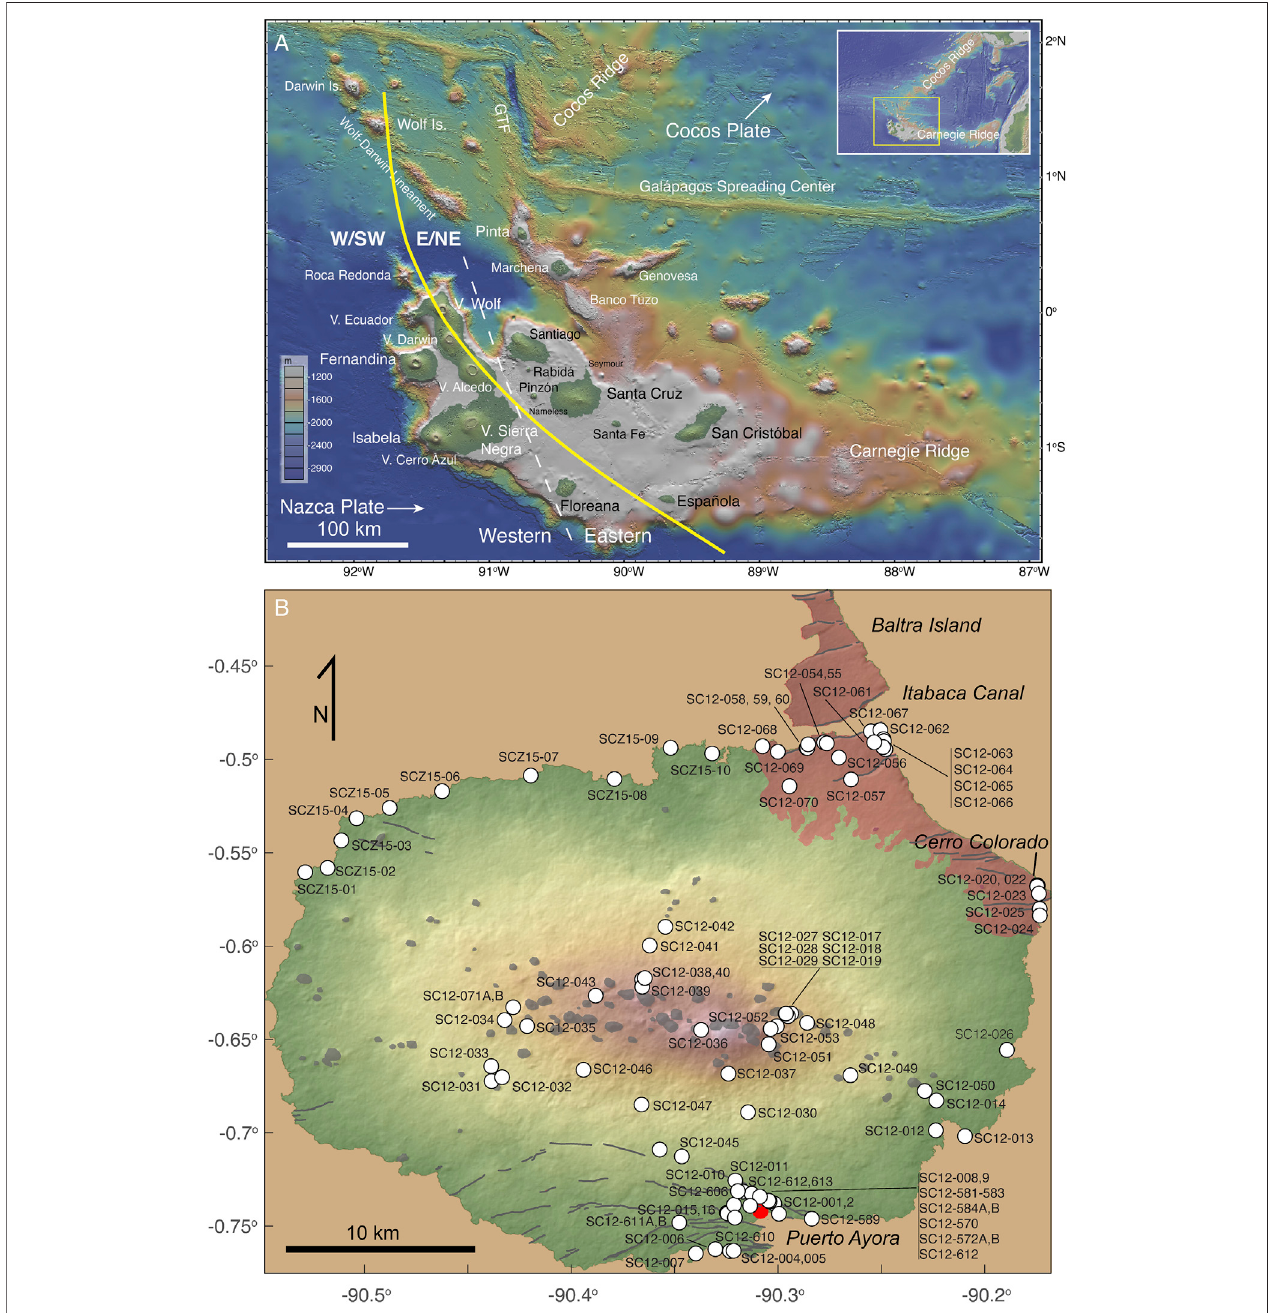
FIGURE 1 | (A) Map of the Galápagos Archipelago. Santa Cruz is located in the central Galápagos. Cocos and Nazca absolute plate motion directions are from Argus et al. (2011). The yellow line denotes the boundary between the enriched, LLSVP-sourced stripe on the W/SW side of the plume and the less enriched, ambient mantle-sourced stripe on the E/NE side of the plume; see text for discussion and Harpp and Weis (2020) for further details. The white dashed line indicates the line betweenthewesternand easternvolcanicmorphologies inthearchipelago. (B) Digital Elevation Model(DEM)ofSanta Cruzwithlocationsforall samplescollected duringthe2012and2015 fi eldexcursionstotheisland.Faultsarerepresentedasgraylines.Cinderandtuffconesarecoloreddarkgray.RedcircleisthetownofPuerto Ayora, and white circles are sampling locations. Light red regions (northeast quadrant and Baltra Island) are Platform Series (Bow, 1979). According to Bow (1979), additional reversely polarized lavas (i.e., > 700 ka Ma) are located in the northwest quadrant, but they are not shown here; consequently, it is possible that samples SCZ15-01 through 06 may be Platform Series as well.